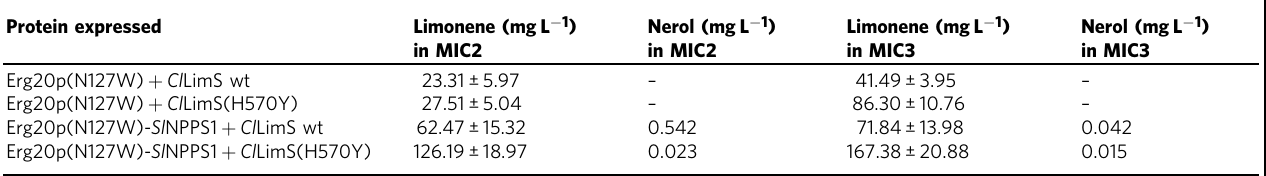
Errors correspond to the mean absolute deviation (MAD) around the mean ( n = 3 biologically independent samples). Source data are provided in a Source Data fi le